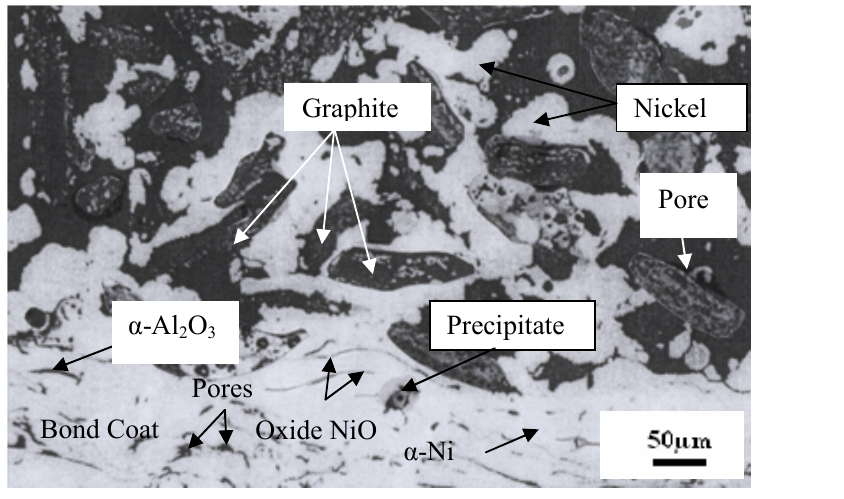
Figure 5 – Microstructure of NiAl / Ni-15% graphite layers deposited with 700A Slika 5 – Mikrostruktura NiAl / Ni-15% grafit slojeva deponovanih sa